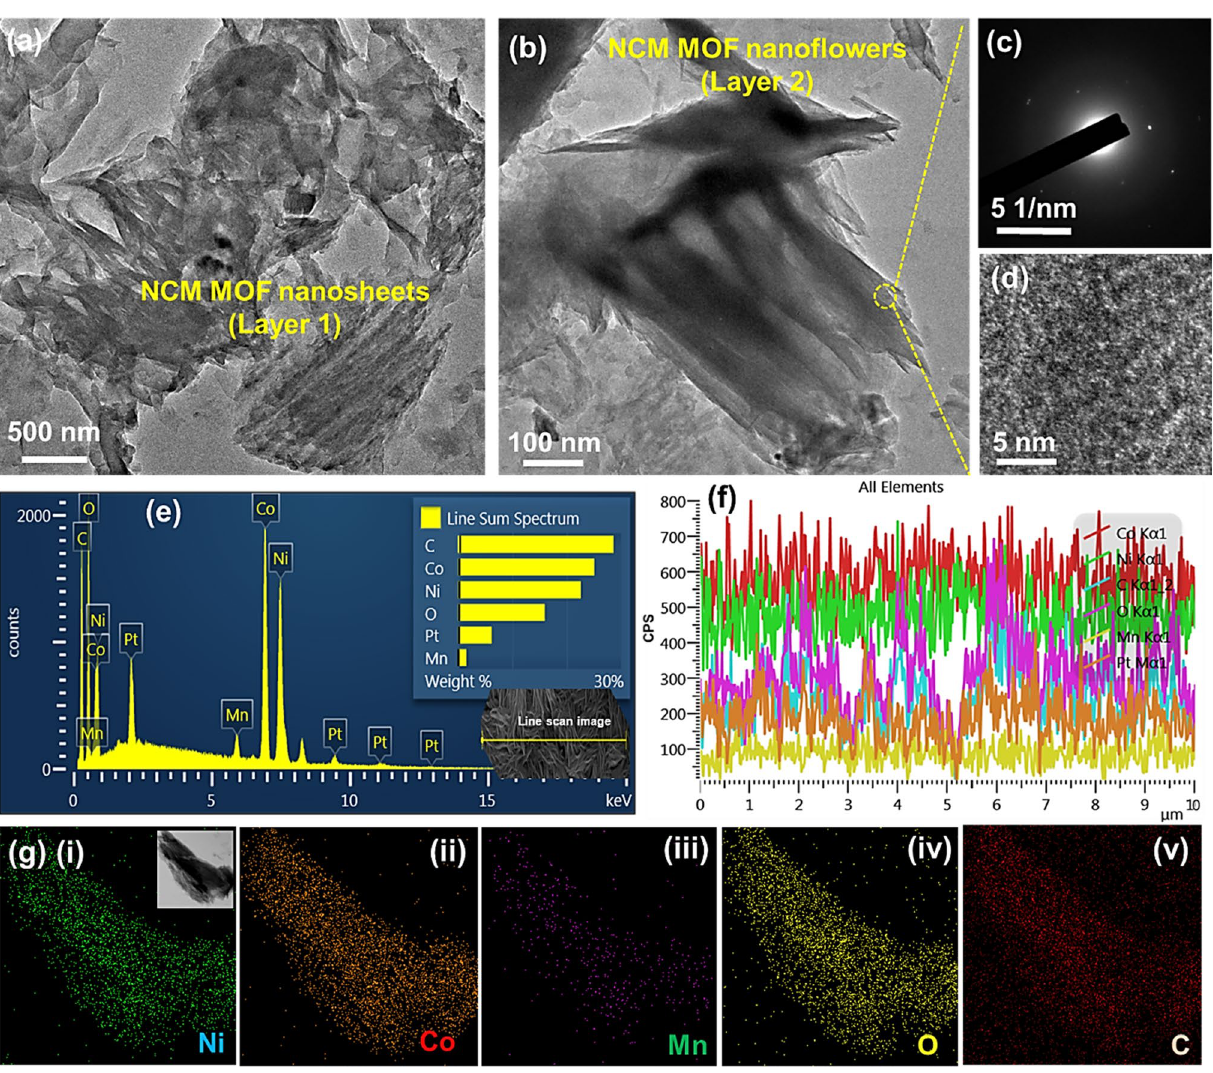
Fig. 2 Morpholgical and elemental analysis of trimettalic NCM-based MOF peeled out from the Ni foam: TEM images of the NCM-based MOF-5/Ni foam, displaying layer 1 composed of a 2D nanosheets and layer 2 composed of b 3D flower-like nanostructures. c Corresponding SAED pattern and d HR-TEM image of the NCM-based MOF-5 nanostructures. e EDX spectrum, f line-scan EDX spectra, and g elemental mapping images of (i) Ni, (ii) Co, (iii) Mn, (iv) O, and (v) C elements of the NCM-based MOF-5